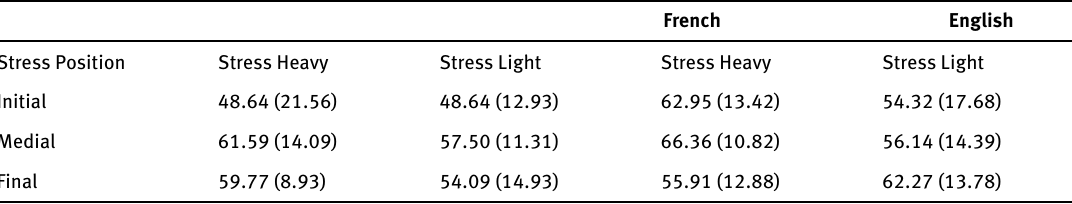
Table 10 Novel word percent correct (SD) by syllable position